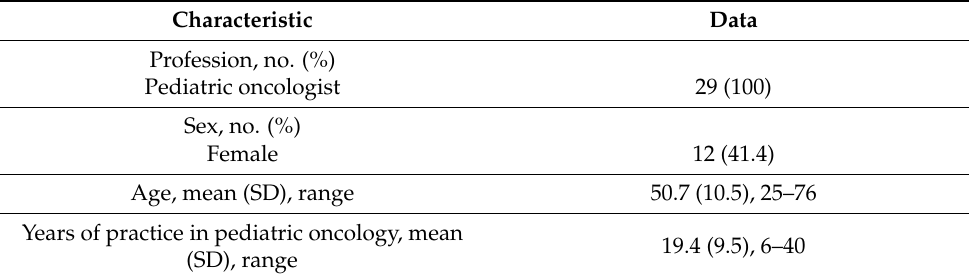
Table 3. Demographics, oncologists (n =